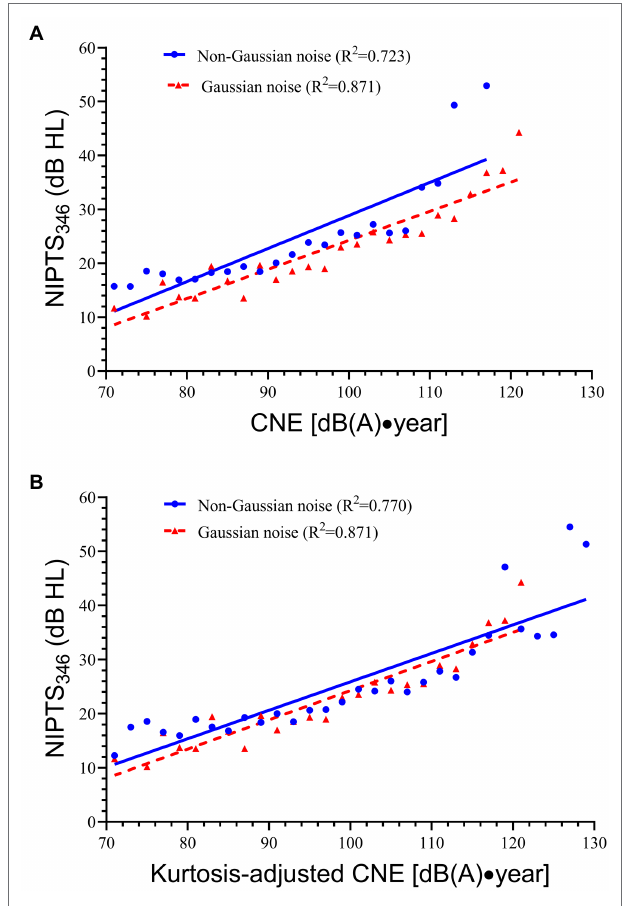
FIGURE 1 | The linear relationship between NIPTS 346 and CNE or CNE ′ for all subjects. (A) The linear relationship between NIPTS 346 and CNE. The regression equation for Gaussian noise is NIPTS 346 = 0.540CNE—29.707, R 2 = 0.871. The regression equation for non-Gaussian noise is NIPTS 346 = 0.613CNE ′ —32.415, R 2 = 0.723. (B) The linear relationship between